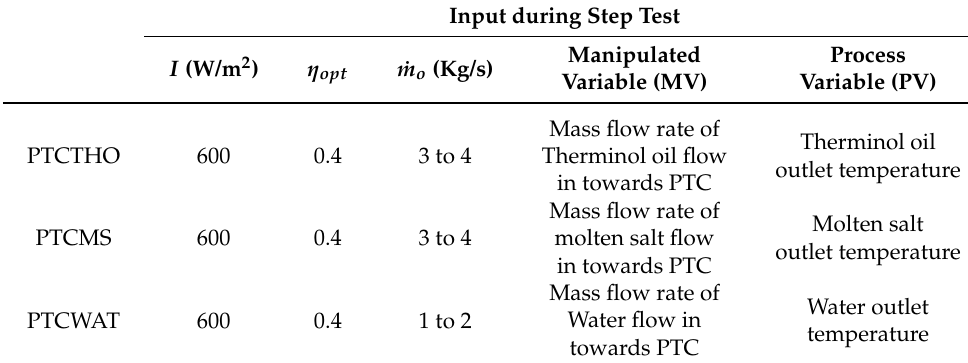
Table 2. Step test inputs for system identification of PTC for HTFs.